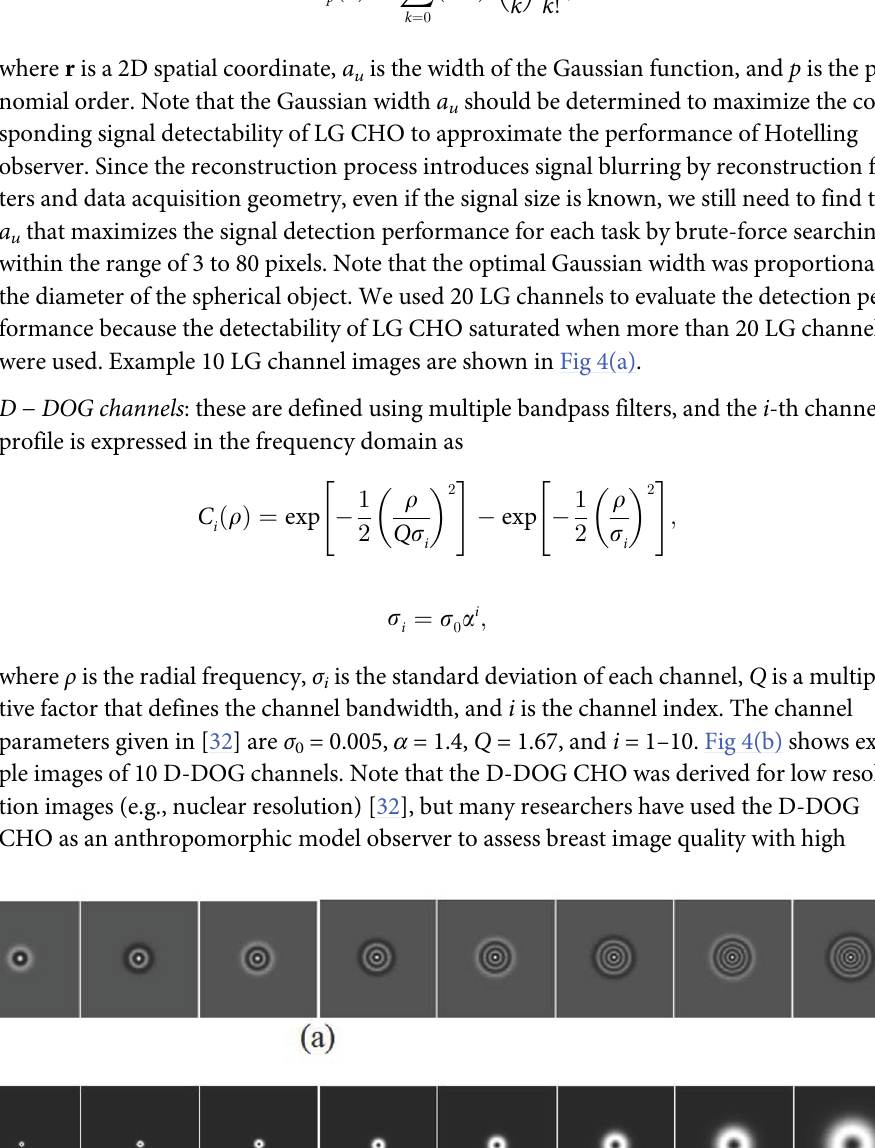
Fig 4. Exampled channels of LG CHO and D-DOG CHO. (a) Exampled 10 number of LG spatial channel images with a p = 9). (b) Exampled 10 number of D-DOG frequency channel images (left: i = 1, right: i = 10).